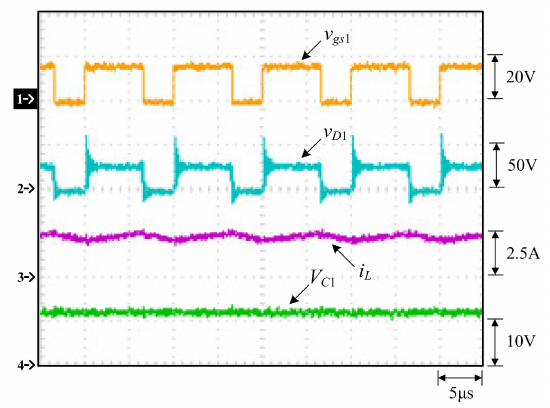
Figure 22. Waveforms measured under the thermoelectric system: (1) v gs 1 ; (2) v D 1 ; (3) i L ; (4) V C 1 .